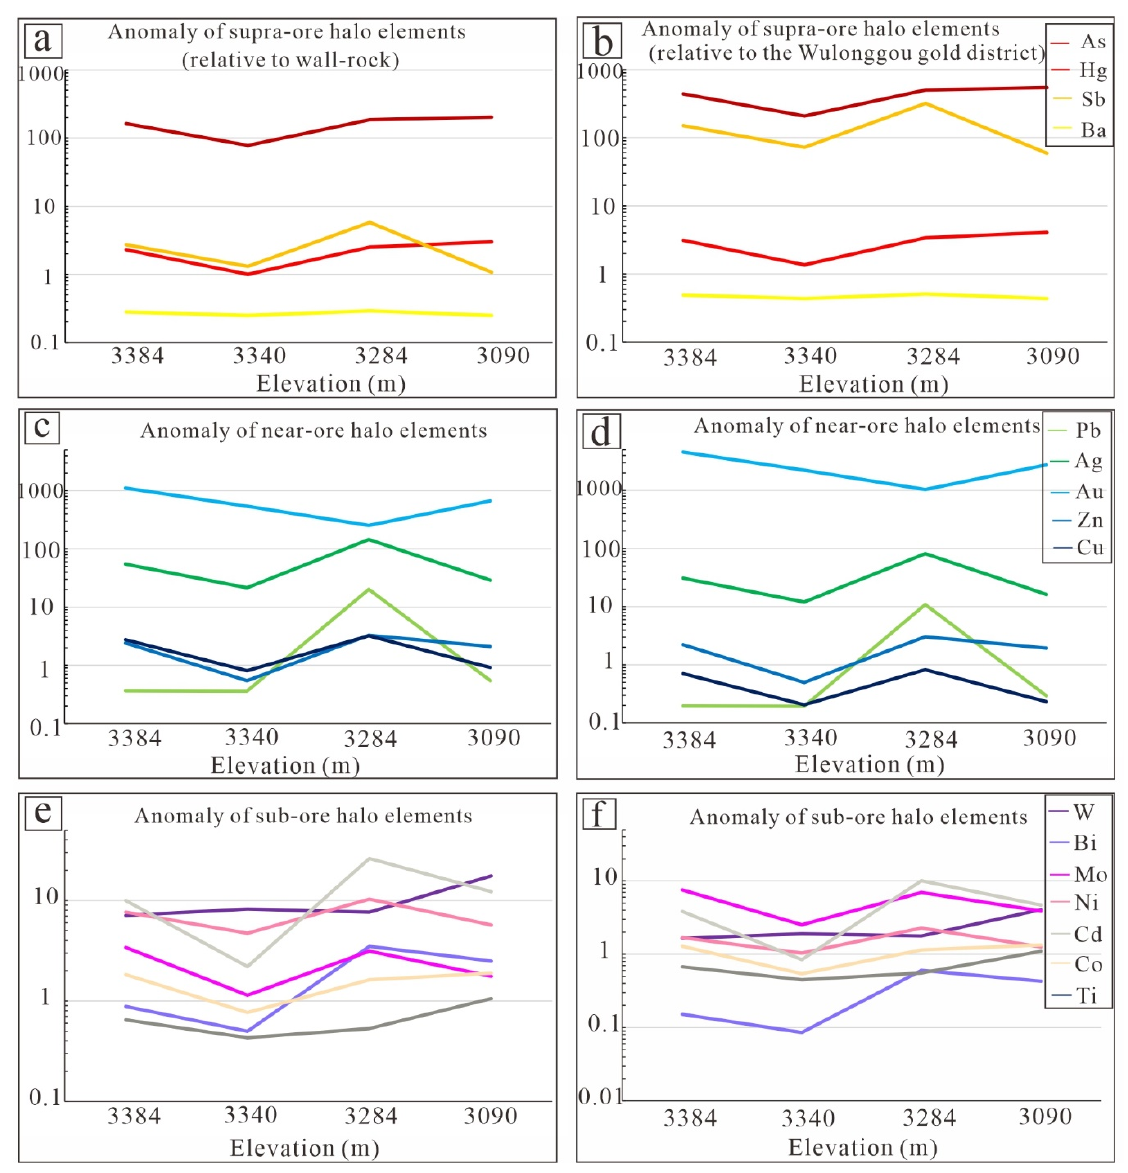
Figure 11. Variation characteristics and trends with different elevation of supra-, near-, and sub-ore halo elements. ( a ), ( c ), and ( e ) are relative to wall-rock. ( b ), ( d ), and ( f ) are relative to the Wulonggou gold district.